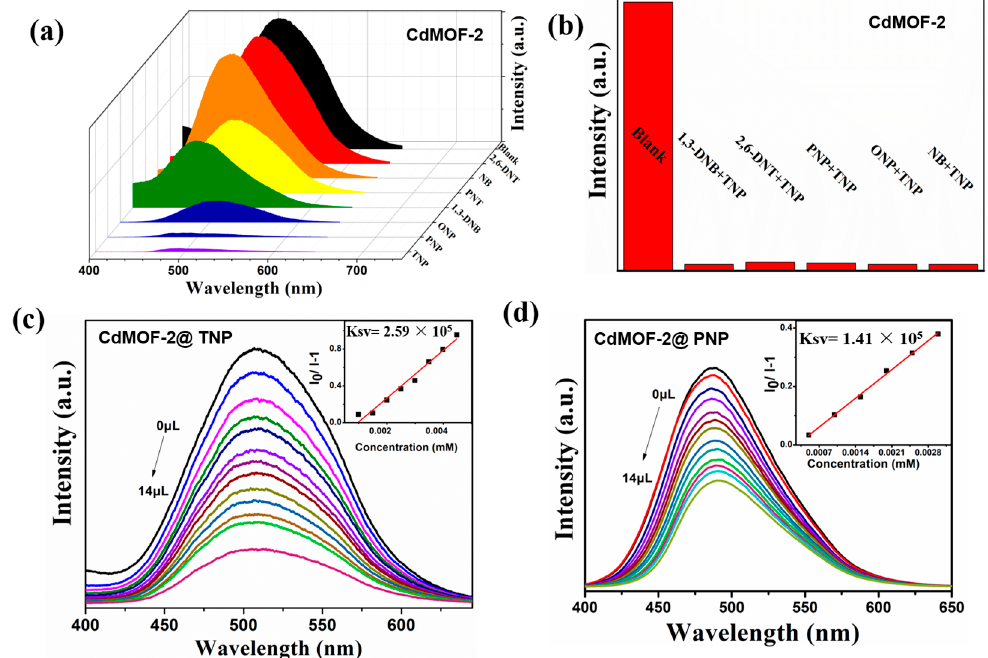
Figure 5. ( a ). The emission intensities of CdMOF-2 dispersed in DMF solution with different NACs (10 − 2 M). ( b ) Anti-interference performance of CdMOF-2 before and after adding with TNP and other NACs. ( c ) Emission intensities of CdMOF-2 with increasing concentrations of TNP in DMF solution, inset into liner correlation at low concentration. ( d ) Emission intensities of CdMOF-2 with increasing concentrations of PNP in DMF solution, inset into liner correlation at low concentration.